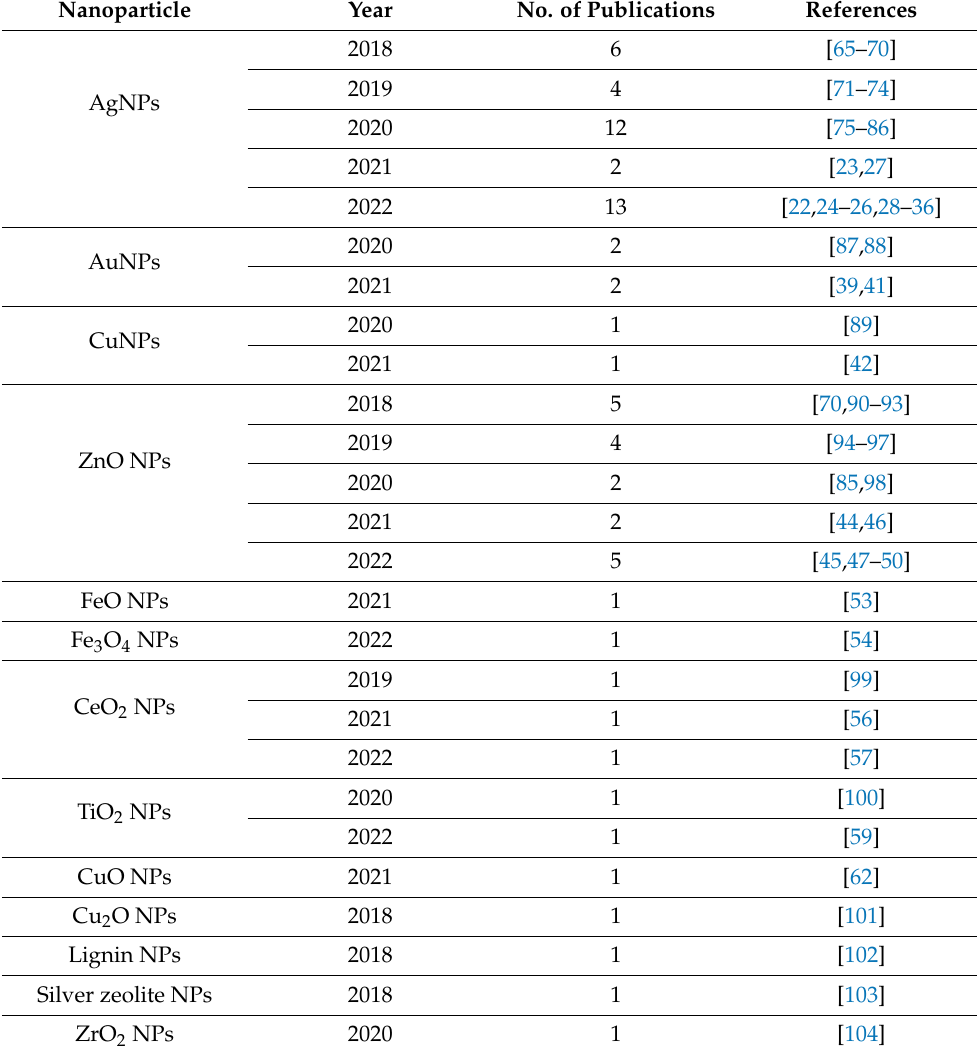
Table 5. The application trends for nanoparticles in the preparation of antimicrobial wound dressings.